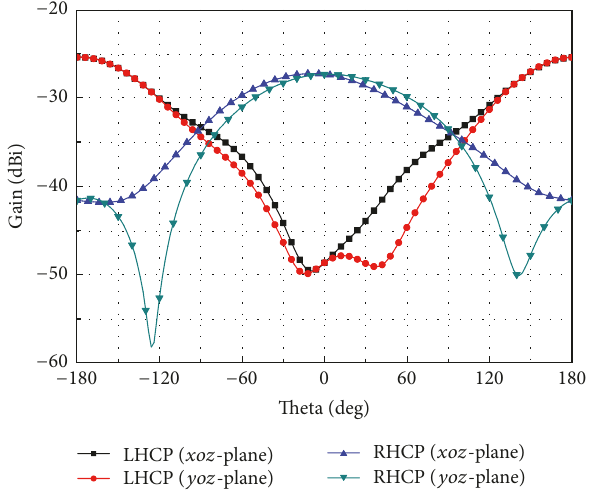
Figure 9: Radiation patterns of the proposed antenna.